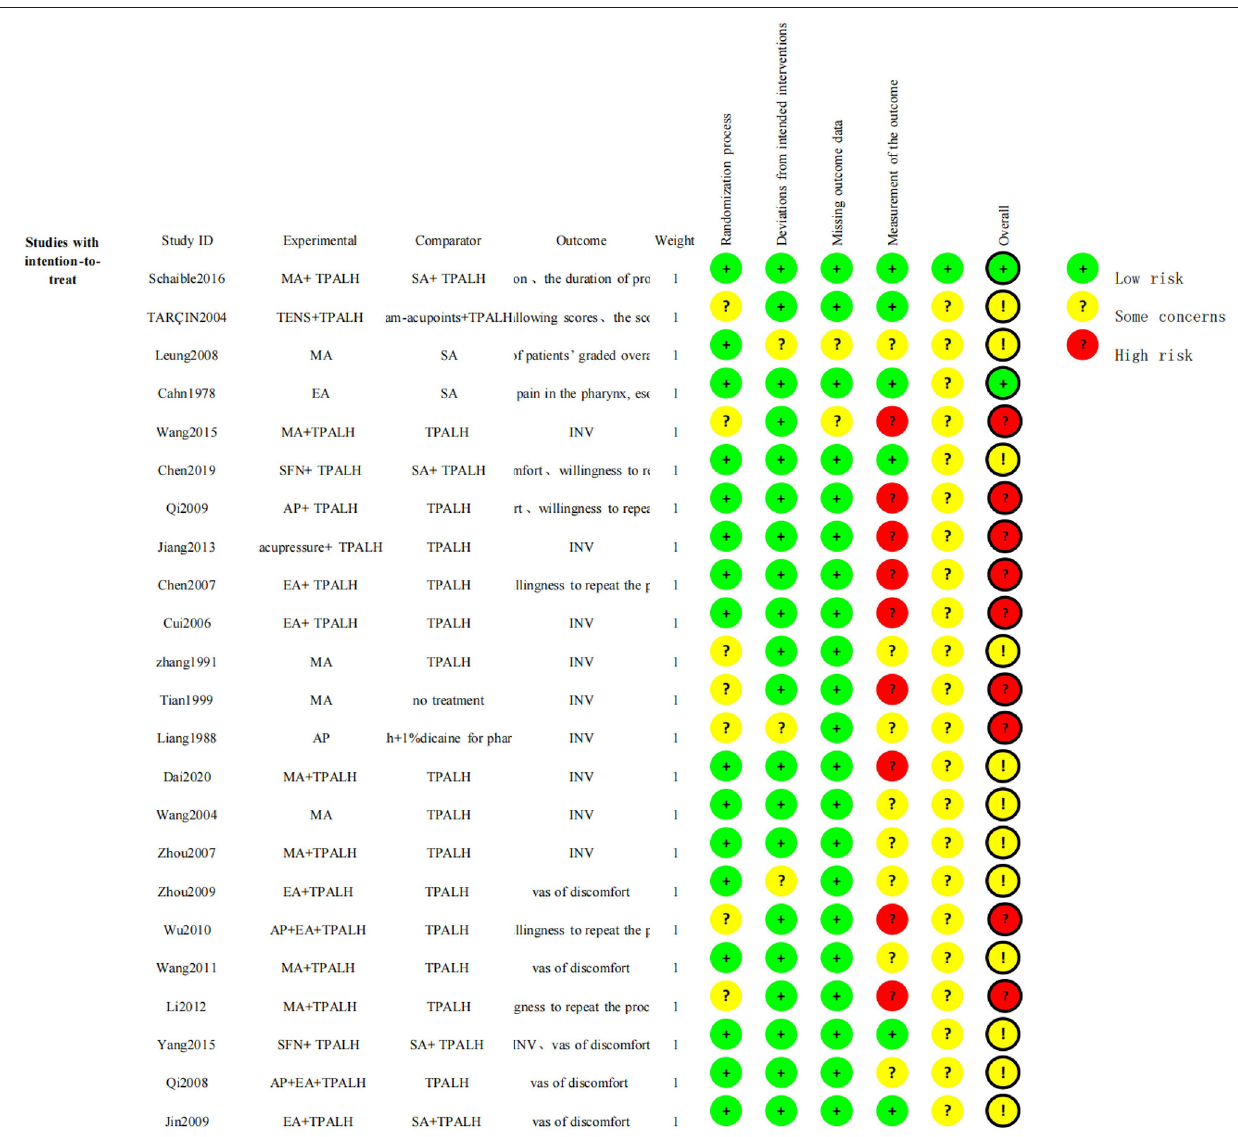
group (RR 0.44, 95% CI 0.31–0.62; P < 0.00001). Cui reported in 2006 that the INV was significantly different between the two groups ( P = 0.045), which was inconsistent with our calculation (RR 0.93, 95% CI 0.74–1.16; P = 0.50). Chen et al. (26) also